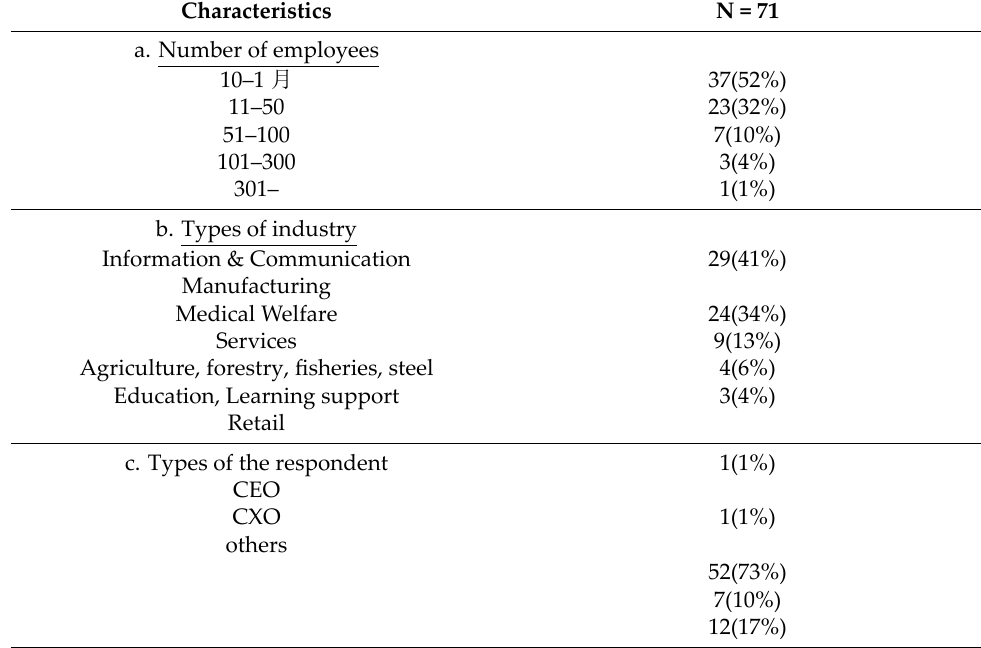
Table 1. Characteristics of the